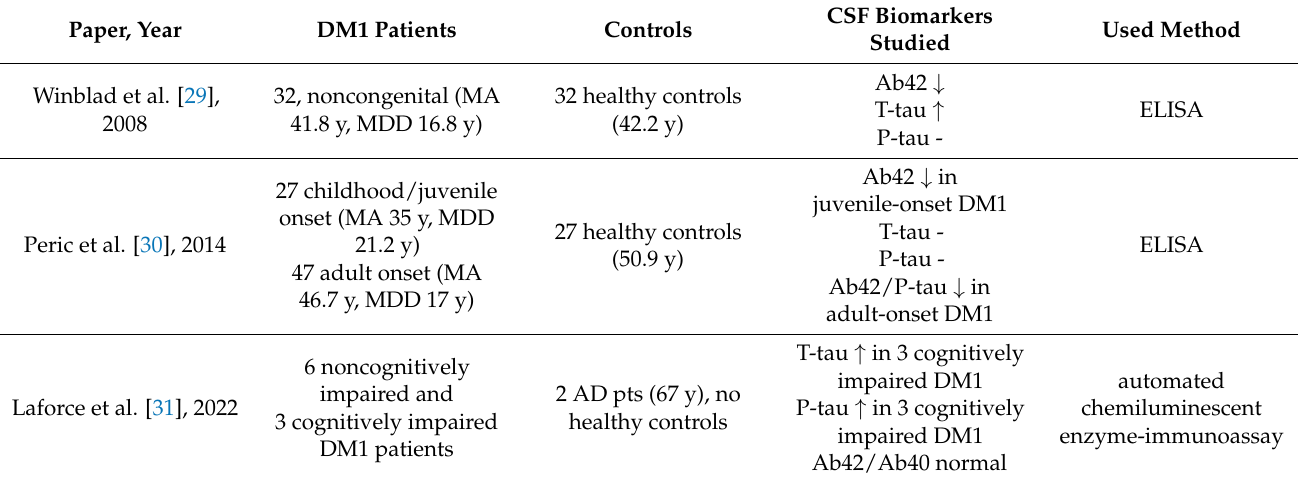
Table 1. Research studies concerning CSF biomarkers of neurodegeneration in DM1. Abbreviations: Ab40: 40-amino-acid form of beta-amyloid, Ab42: 42-amino-acid form of beta-amyloid, CSF: cere- brospinal fluid, DM1: myotonic dystrophy type 1, ELISA: enzyme-linked immunosorbent assay, MA: mean age, MDD: mean disease duration, P-tau: phosphorylated tau, T-tau: total tau, y: